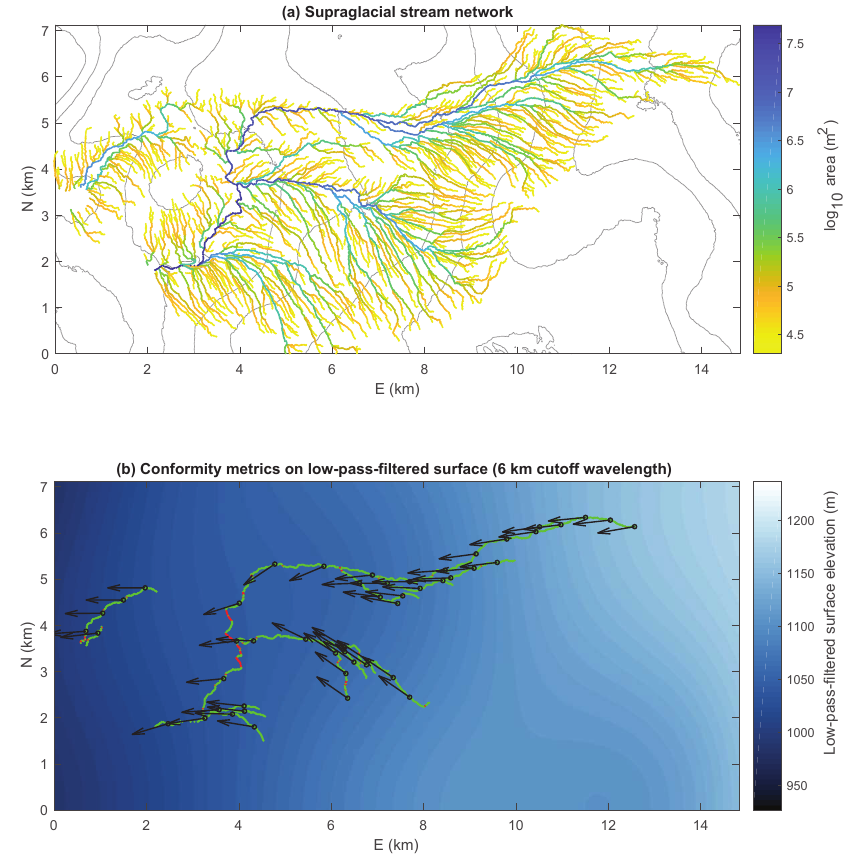
Figure 6. (a) Supraglacial stream network obtained by flow routing on 2m DEMs from study region R1 (Fig. 1a, Table 1), colored by accu- mulated upstream drainage area. Surface elevation is shown with 20m black contours. Fluvial incision rate should increase with increasing slope and drainage area (Eq. 7). (b) Illustration of stream conformity metrics for select streams from the same network, projected onto topog- raphy low-pass filtered at a 6km cutoff wavelength. Sections of streams that would be flowing uphill on this filtered surface are colored red and other sections are green; these data are used to calculate percent downhill % d . Black arrows indicate the steepest descent directions on this filtered surface; the angle between these directions and the corresponding stream channel orientations is used to calculate the conformity factor (cid:51)